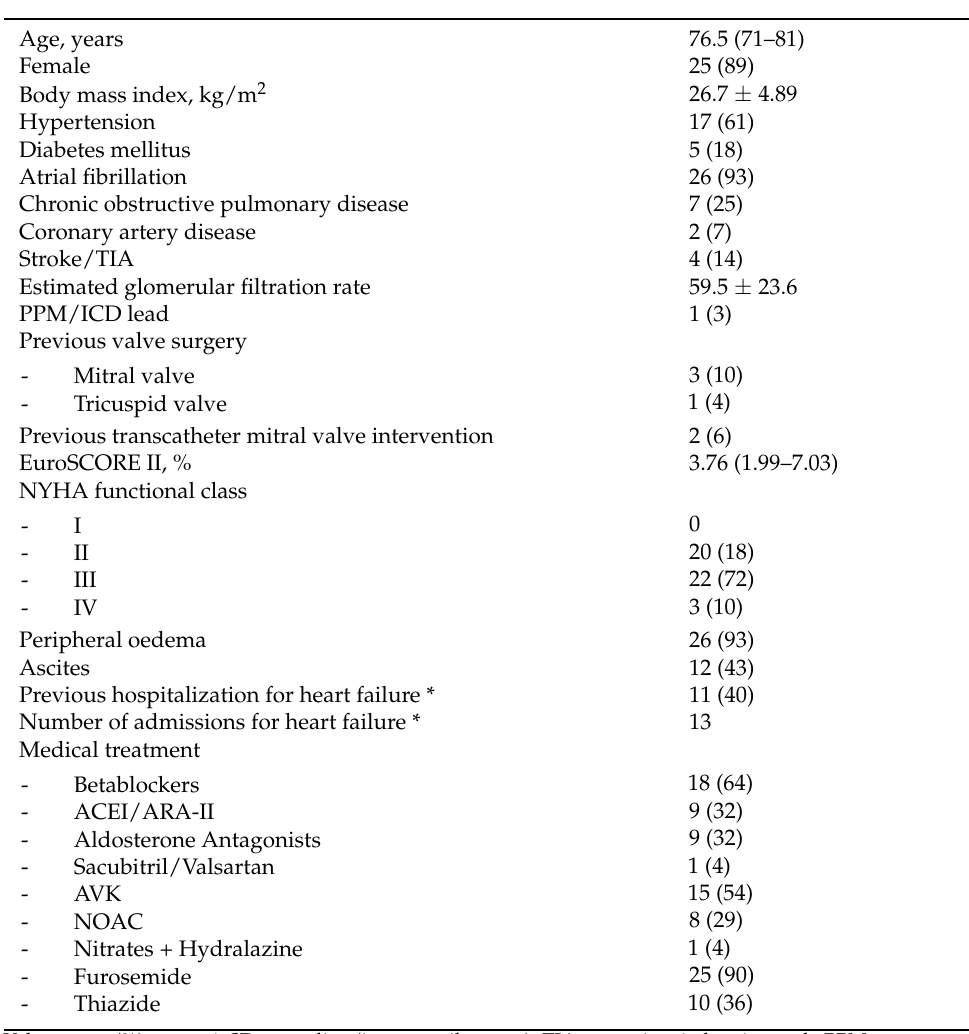
Table 1. Baseline clinical characteristics (N =